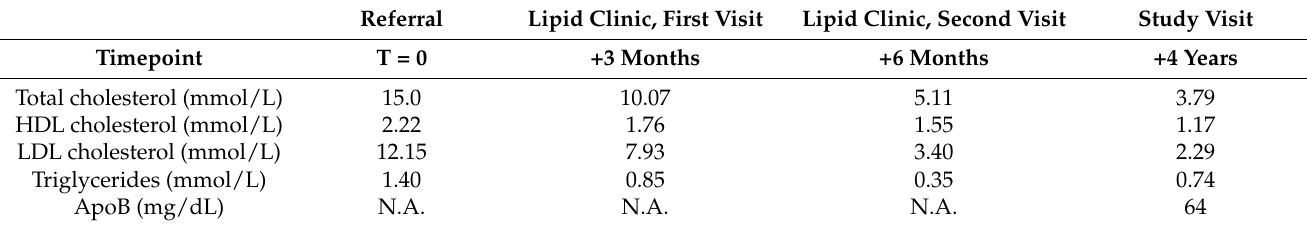
Table 2. Lipid panels of patient